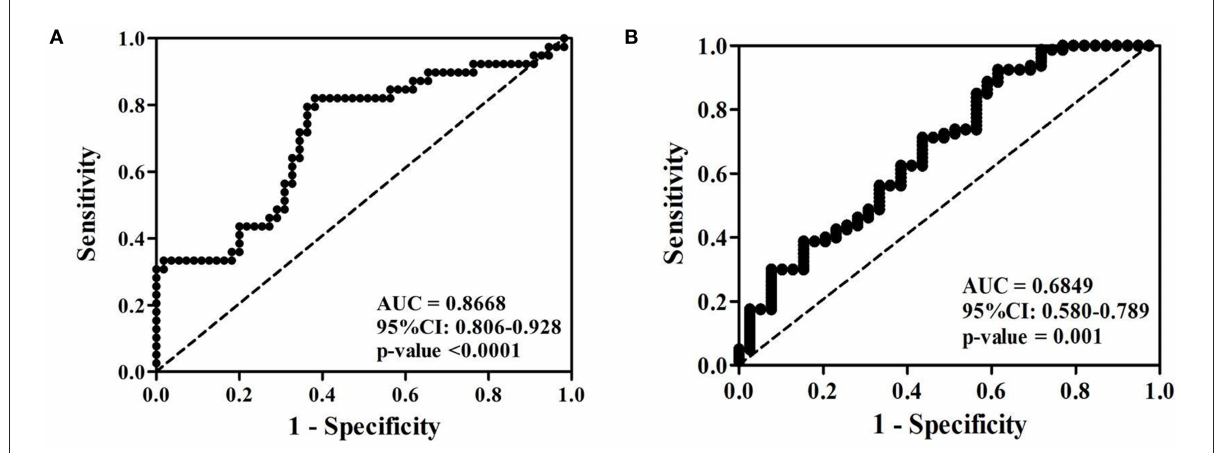
TABLE 2 The sensitivity, specificity, and accuracy values of currently used serum markers and PTPRS for distinguishing patients with CCA from those with BBD. Marker a Sensitivity (%) Specificity (%) Accuracy (%) AUC (%) P -value PTPRS 92.5 38.5 74.8 0.6849 0.001* CEA 81.8 26.7 63.9 0.6093 0.079 67.7 32.5